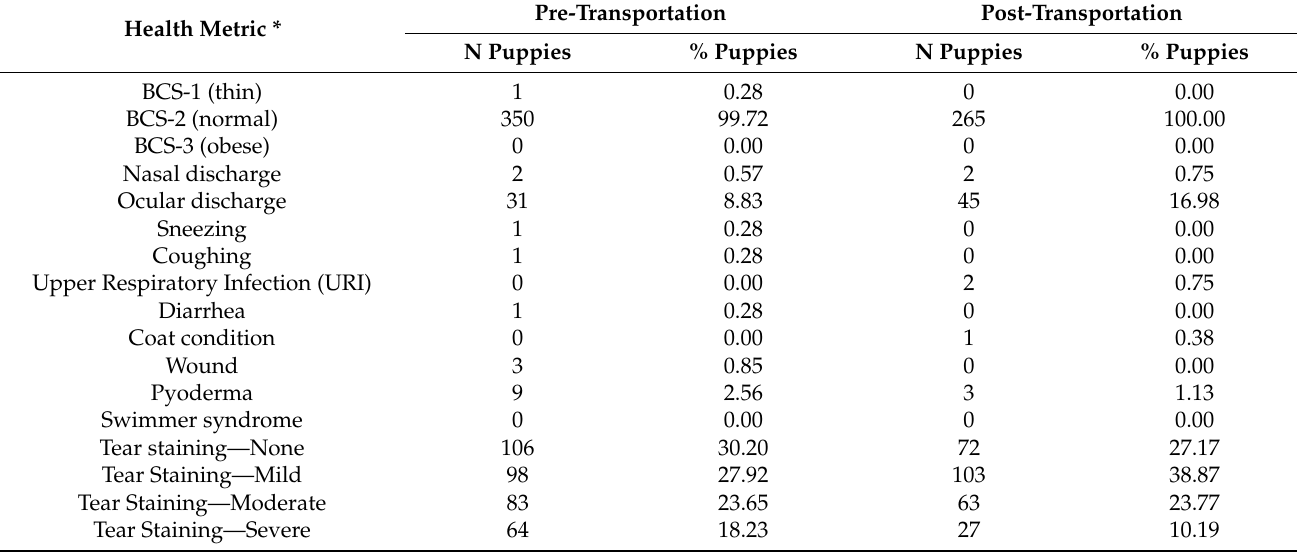
Table 6. Number and percentage 1 of puppies per each health condition pre- and